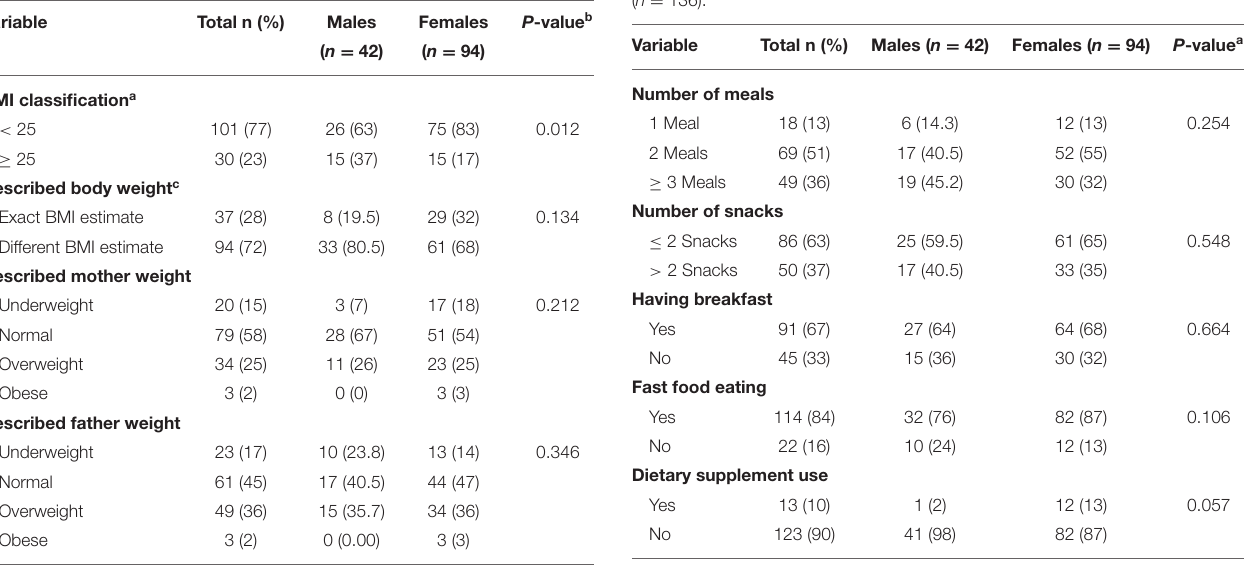
TABLE 2 | Body weight status stratified by gender ( n = 136).